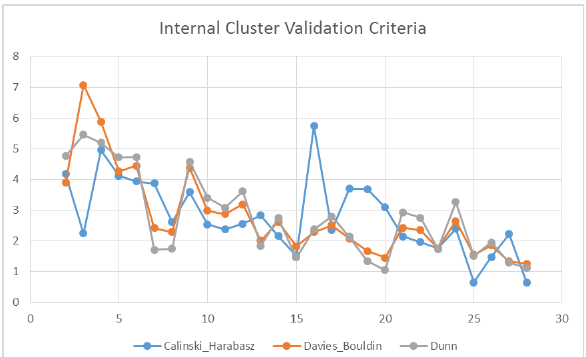
Figure 3. Regularized cluster validation criteria